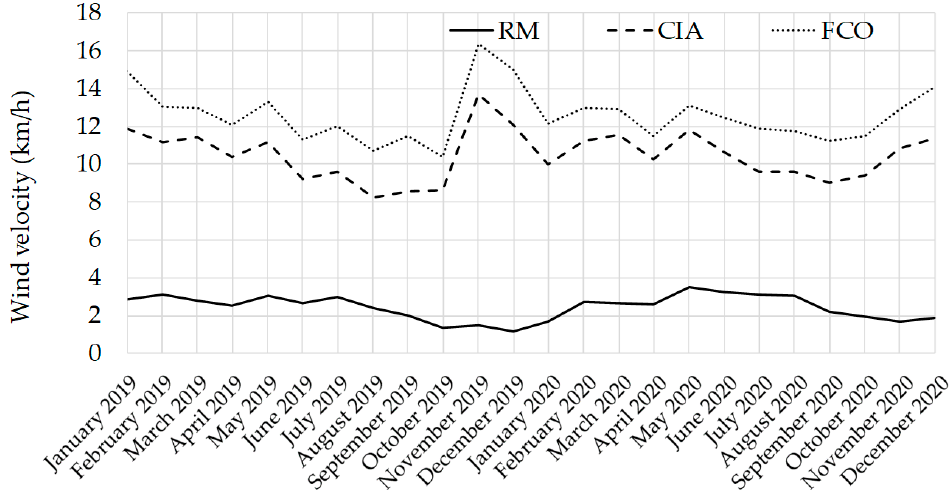
Figure 4. Monthly wind velocity values recorded in Rome, Fiumicino and Ciampino.